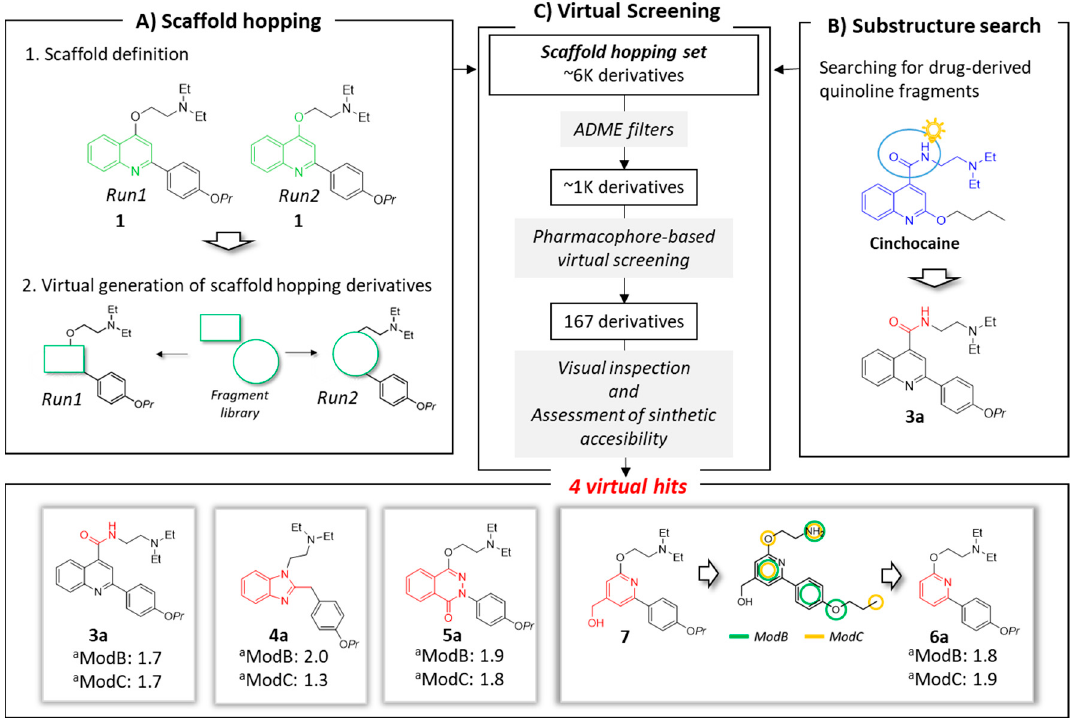
Figure 2. Schematic overview of applied in silico workflow. Panel A: two scaffold hopping runs were performed. In each run, the scaffold (highlighted in green) was virtually replaced using fragments derived by FDA-approved drugs. Panel B: drug-derived quinoline fragments were checked. The cinchocaine fragment Prestw-frag-3758 was highlighted in blue. This structure suggested the replacement of the ether linker in the quinoline family (e.g., inhibitor 1 ) with an amide (represented in red). Panel C: virtual screening process and selected virtual hits. Virtual hits 4a , 5a and 6a derived from the Prestwick fragments Prestw-frag-1560, Prestw-frag-2136 and Prest-frag-2303, respectively, that are highlighted in red. The chemical features of ModB and ModC are shown in green and yellow, respectively. a Fitness